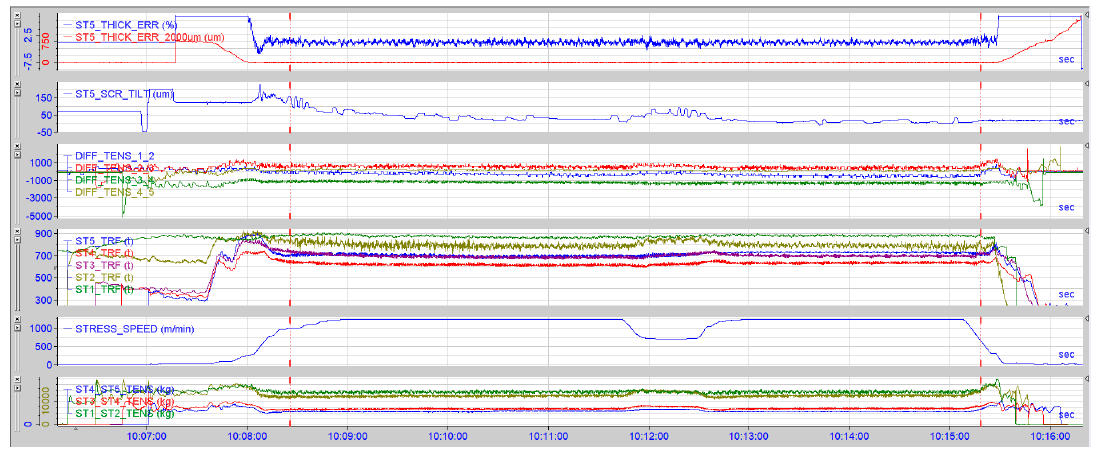
Figure 13. Forces during slow-down of the rolling